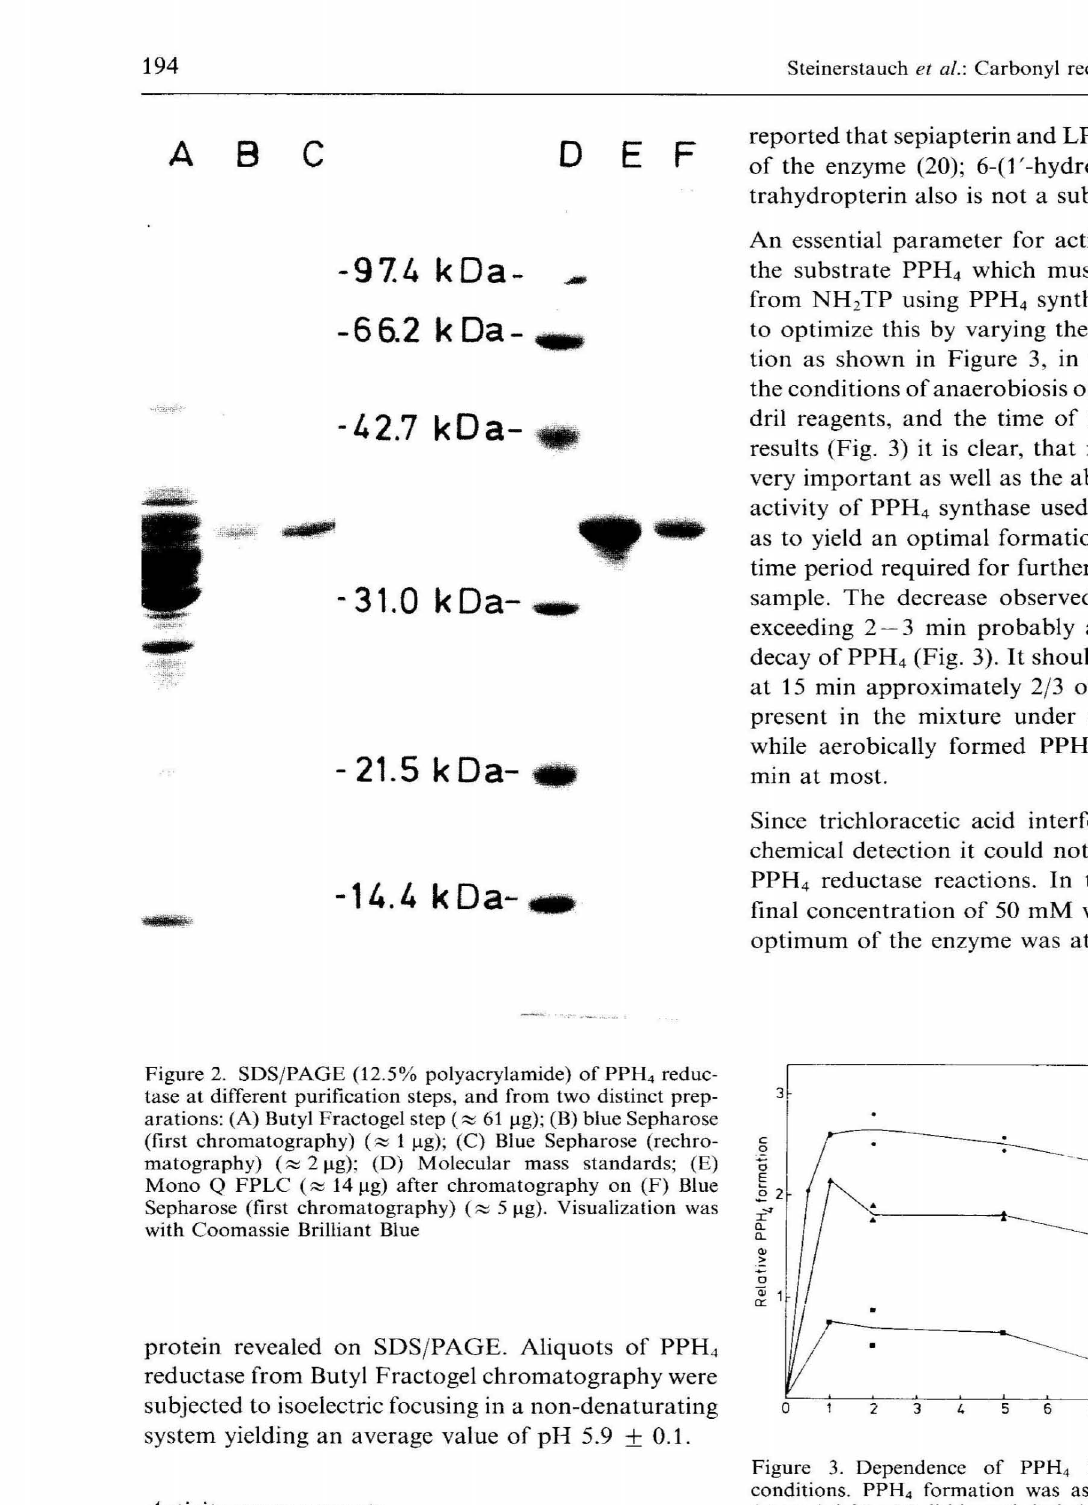
4 Figure 3. Dependence of PPH 4 formation on anaerobic conditions. PPH 4 formation was assayed in the presence of (-.-.-) 0.25 mM dithioerythritol; (A6) 10 mM dithioerythri tol and (-e-e-) anaerobically in the presence of 0.25 mM dithioerythritol, 10 mM glucose, 12 U glucose oxidase and 4'800 U catalase. The reaction mixture further contained 0.1 M potassium phosphate buffer, pH 7.0, 8 mM MgCb, 10 mM PPH 4 synthase and 10 IlM NH 2 TP. The mixture was